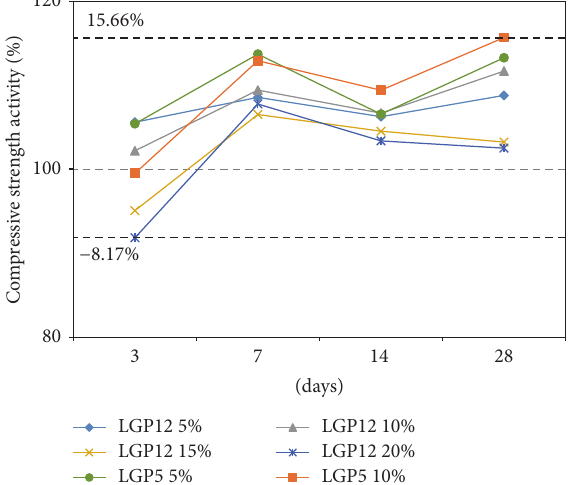
Figure 6: Relationship of compressive strength activity and